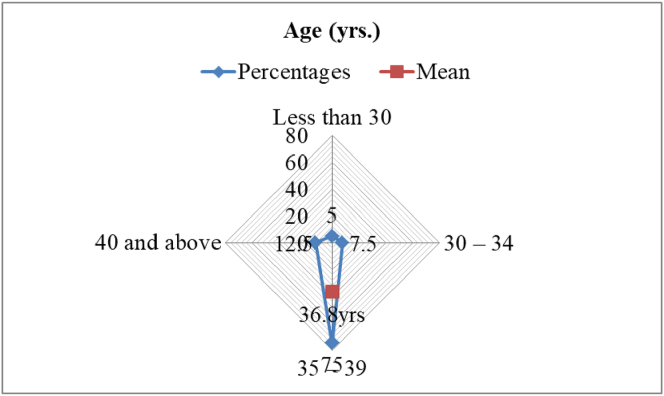
Radar showing the age distribution of the respondents. Source: Field Survey (2020).